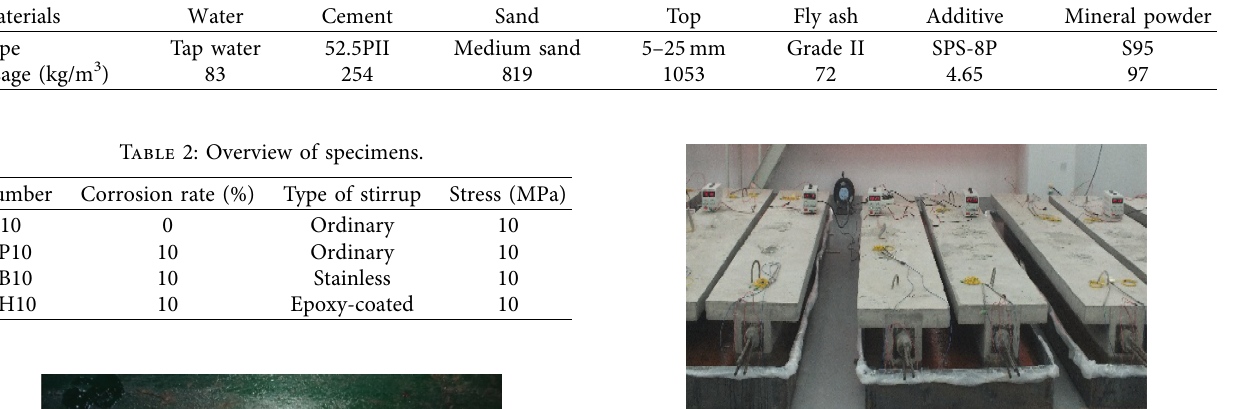
Figure 4: Arrangement of prestressed tendons of model beam (mm). Table 1: Mix proportion of concrete.